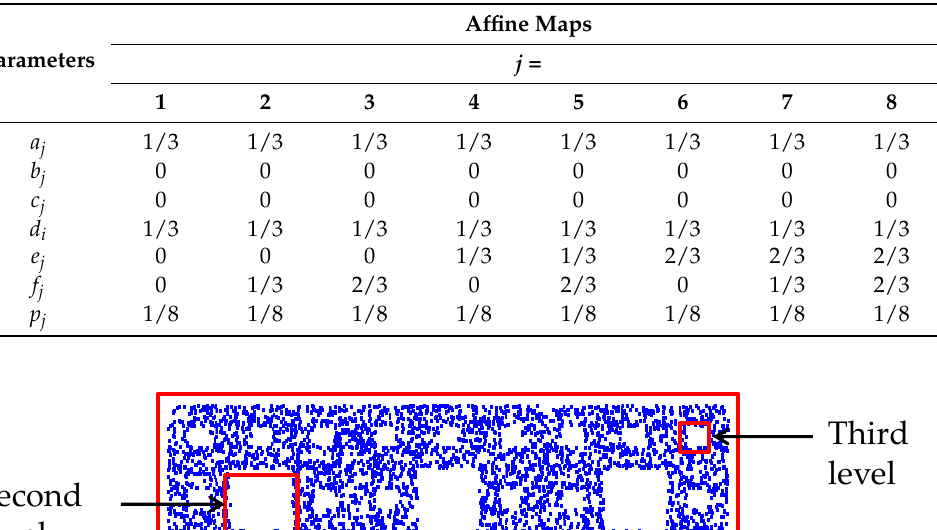
Table 1. Settings of the Sierpinski Carpet [74].